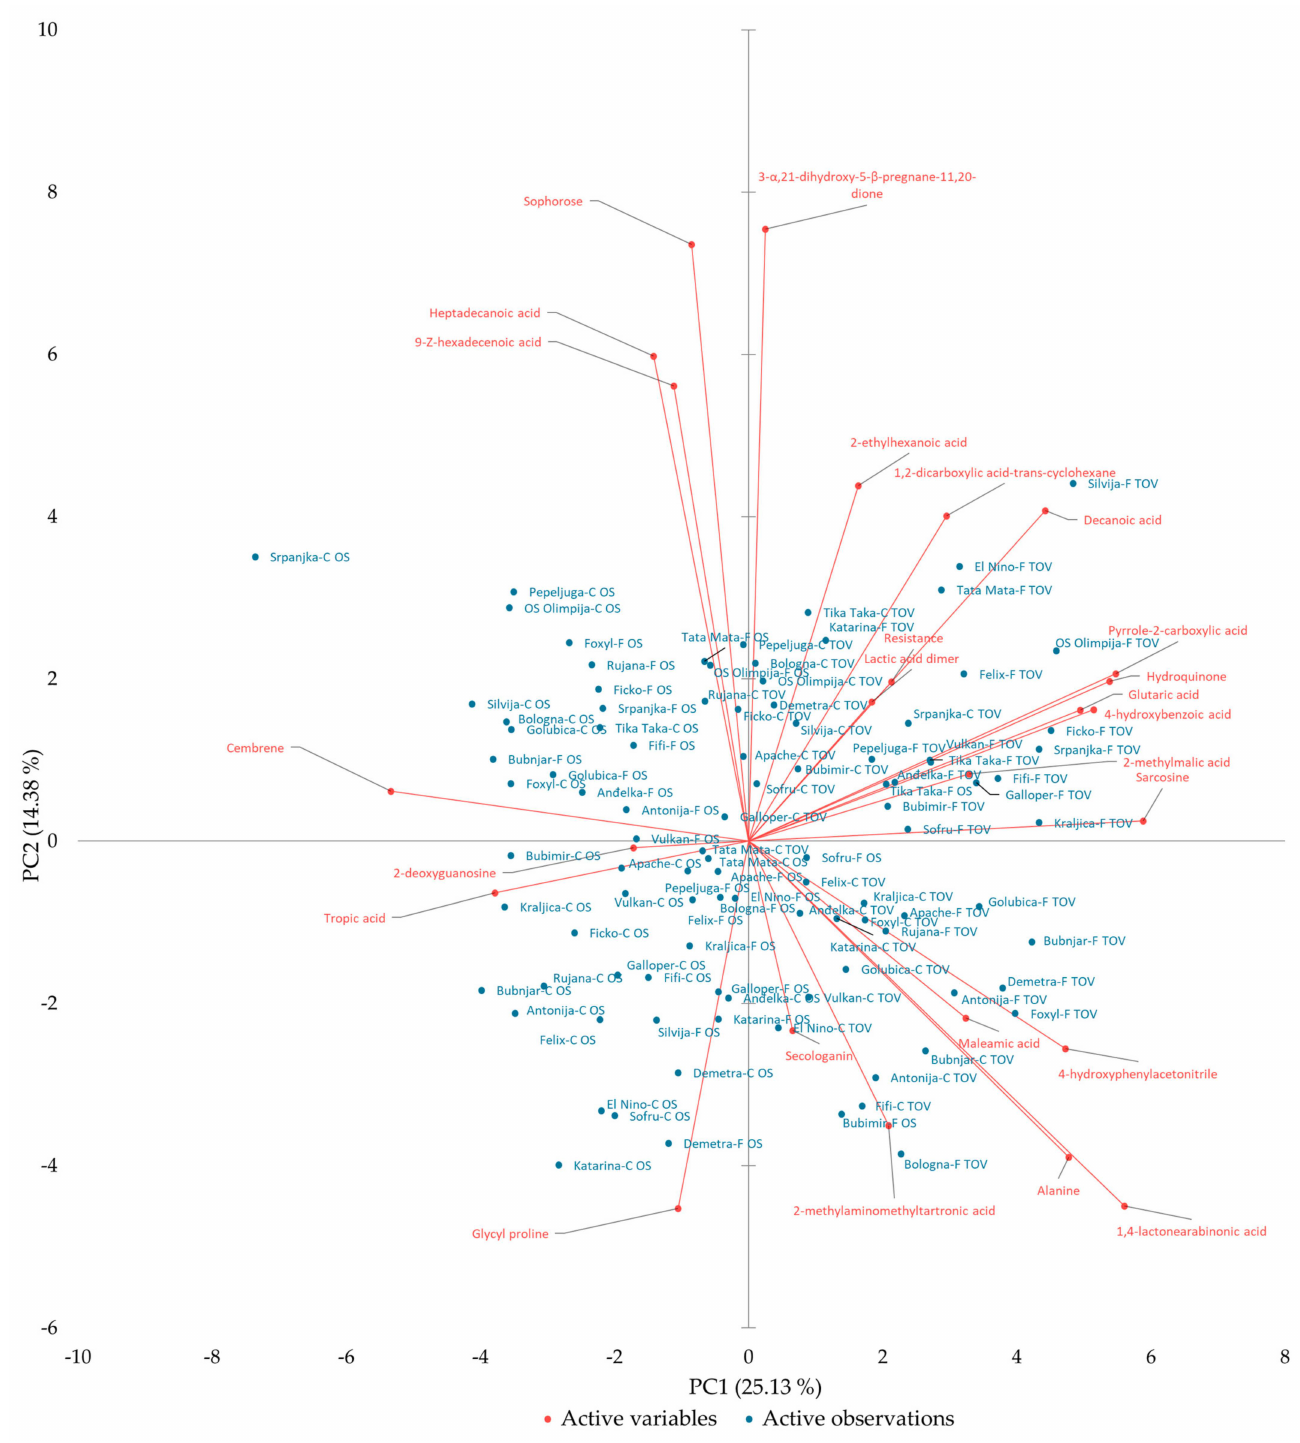
Figure 3. PCA bi-plot of 24 wheat metabolites in the grains and varietal resistance to Fusarium of 25 winter wheat varieties under controlled and Fusarium treatments at both